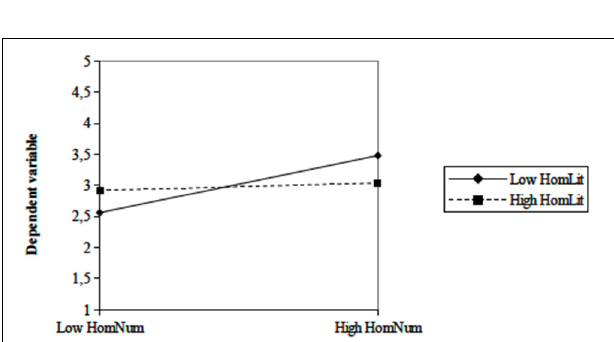
FIGURE 3 | Interaction effect of home literacy and home numeracy on symbolic